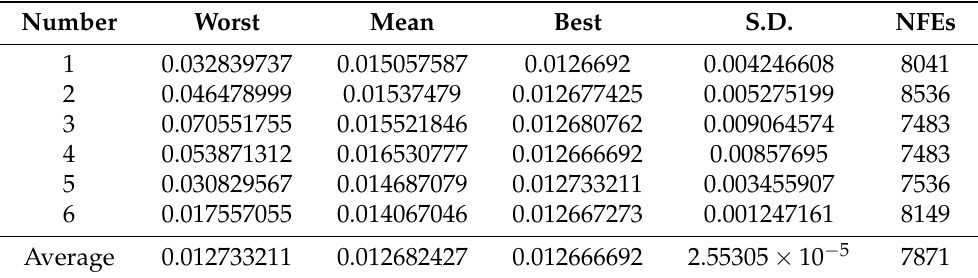
Table 5. Statistical results for the tension/compression spring problem by MAM.